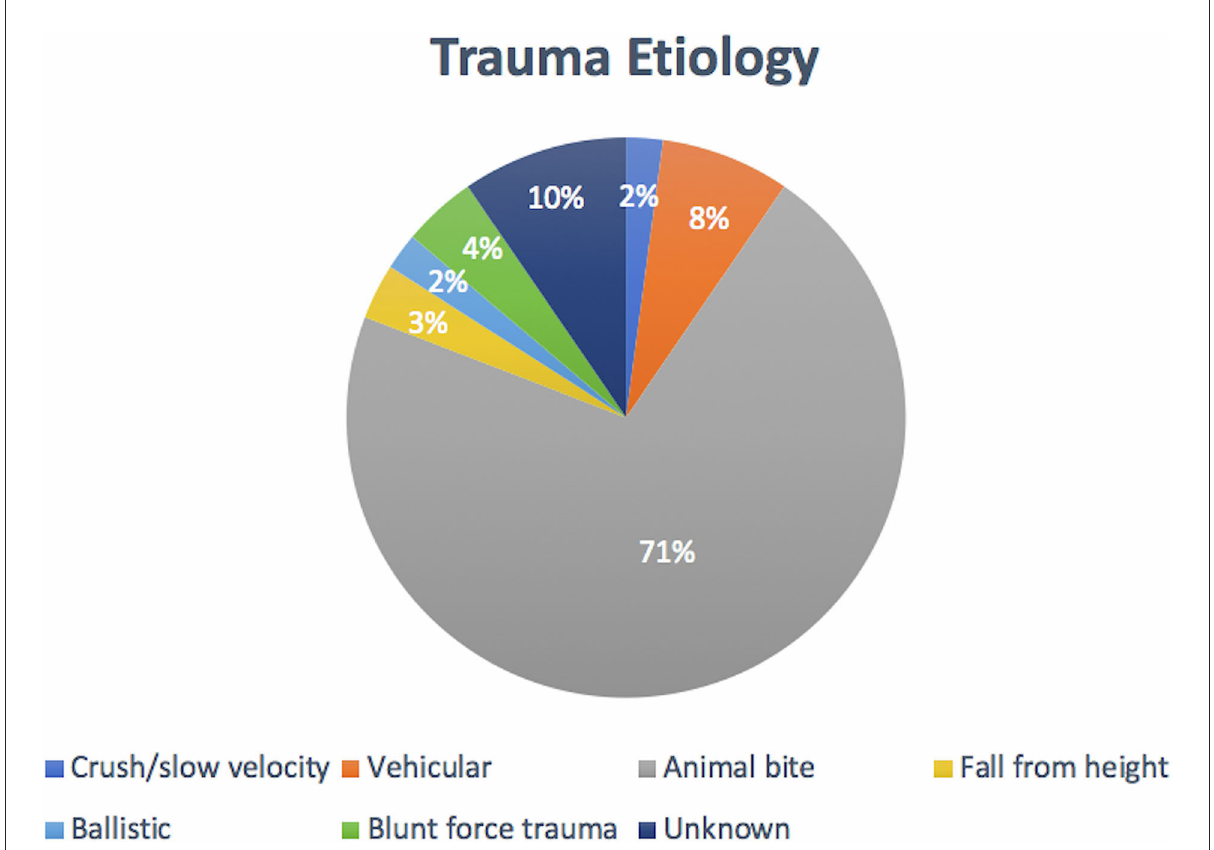
FIGURE8 Distribution of trauma etiology. Note that animal bites accounted for the largest proportion of trauma